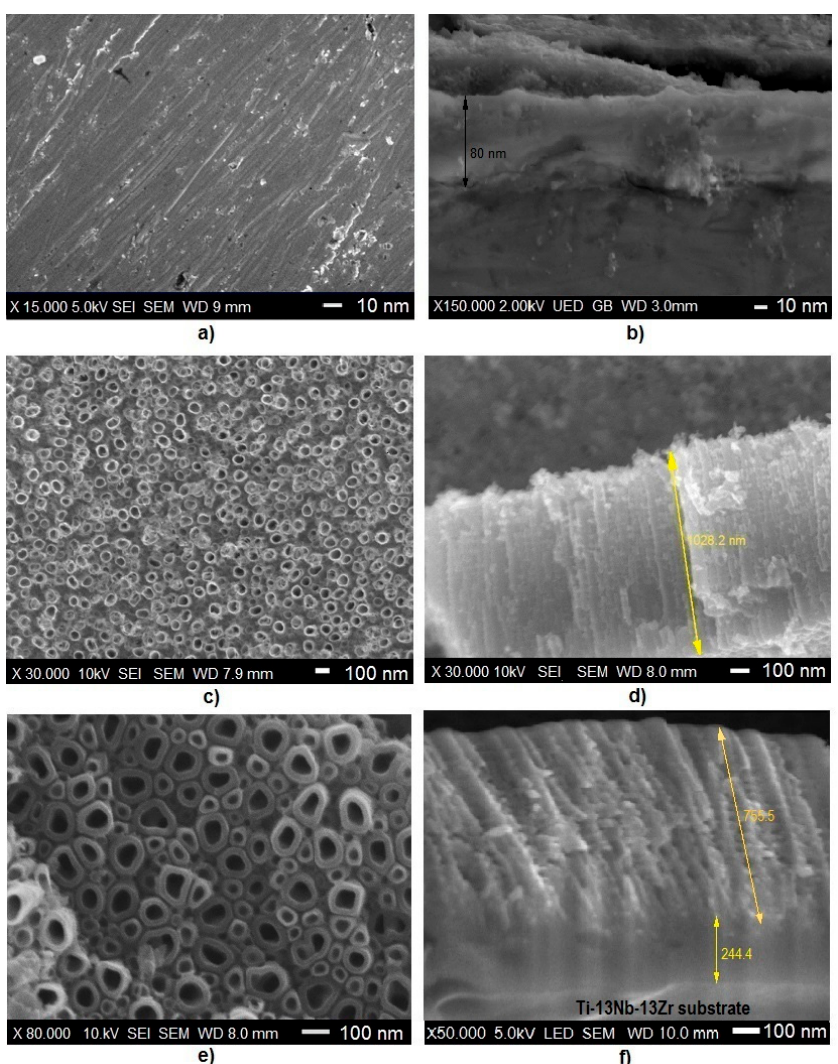
Figure 2. Images SEM - comparison of ( a ) alloy after amorphous layers (EO1) treatment (surface); ( b ) alloy after EO1 treatment (cross-section); ( c ) alloy after nanotubular layer (EO2) treatment (surface); ( d ) alloy after EO2 treatment (cross-section); ( e ) alloy after EO1 + EO2 treatment (surface), ( f ) alloy after EO1 + EO2 treatment (cross-section).